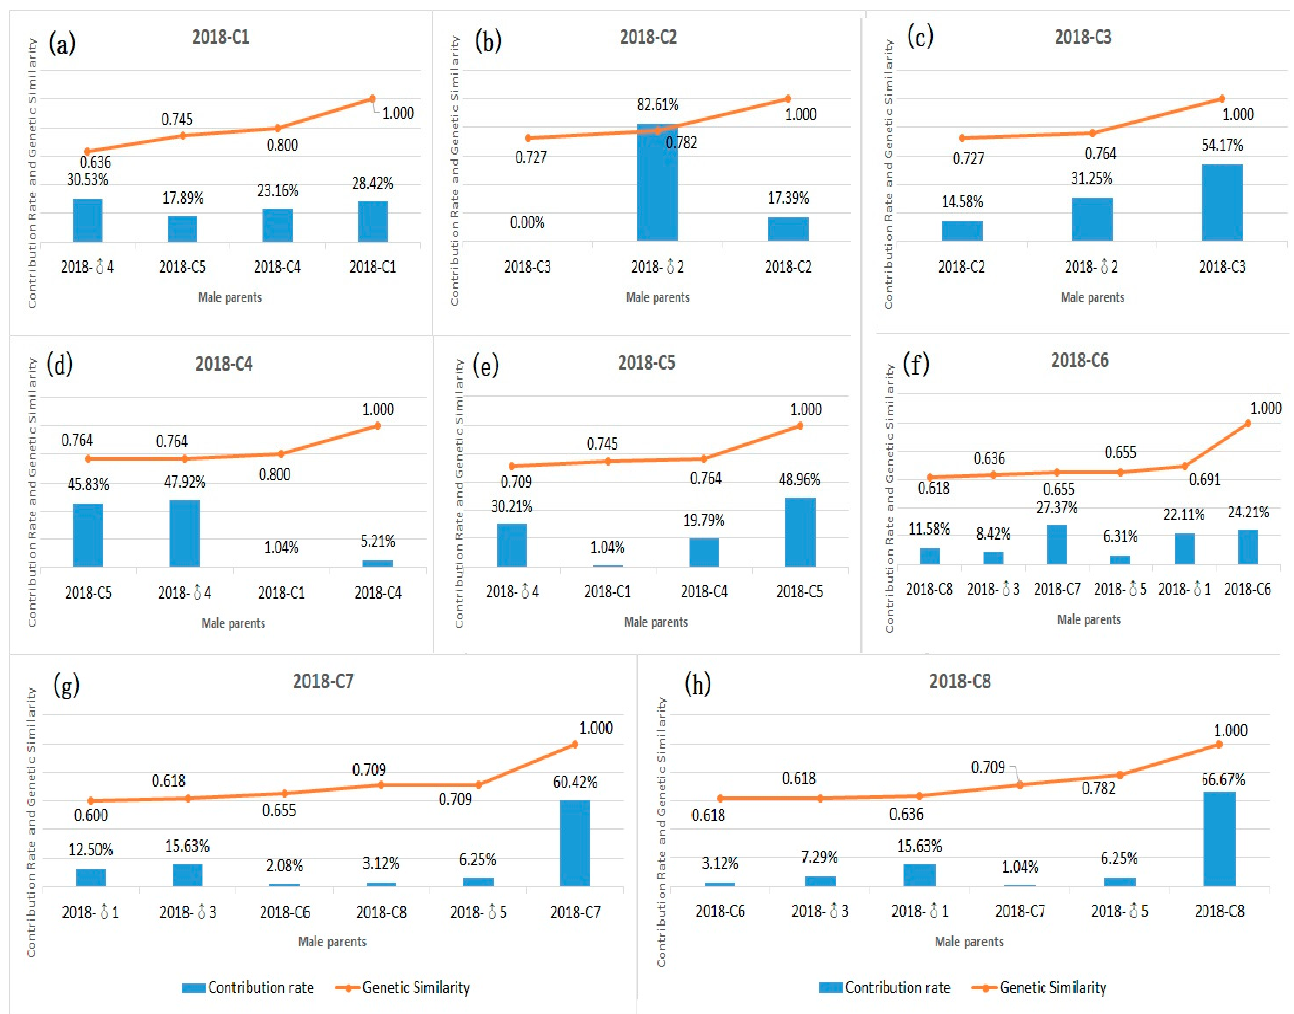
Figure 11. Contribution rate of each male parent and genetic similarity between each male parent and the female parent for the hybrid combinations: ( a ) ♀ 2018-C1, ( b ) ♀ 2018-C2, ( c ) ♀ 2018-C3, ( d ) ♀ 2018-C4, ( e ) ♀ 2018-C5, ( f ) ♀ 2018-C6, ( g ) ♀ 2018-C7, and ( h ) ♀ 2018-C8. Table 3. Correlation of the genetic similarity and mating affinity of the male and female parents at different stages after pollination.